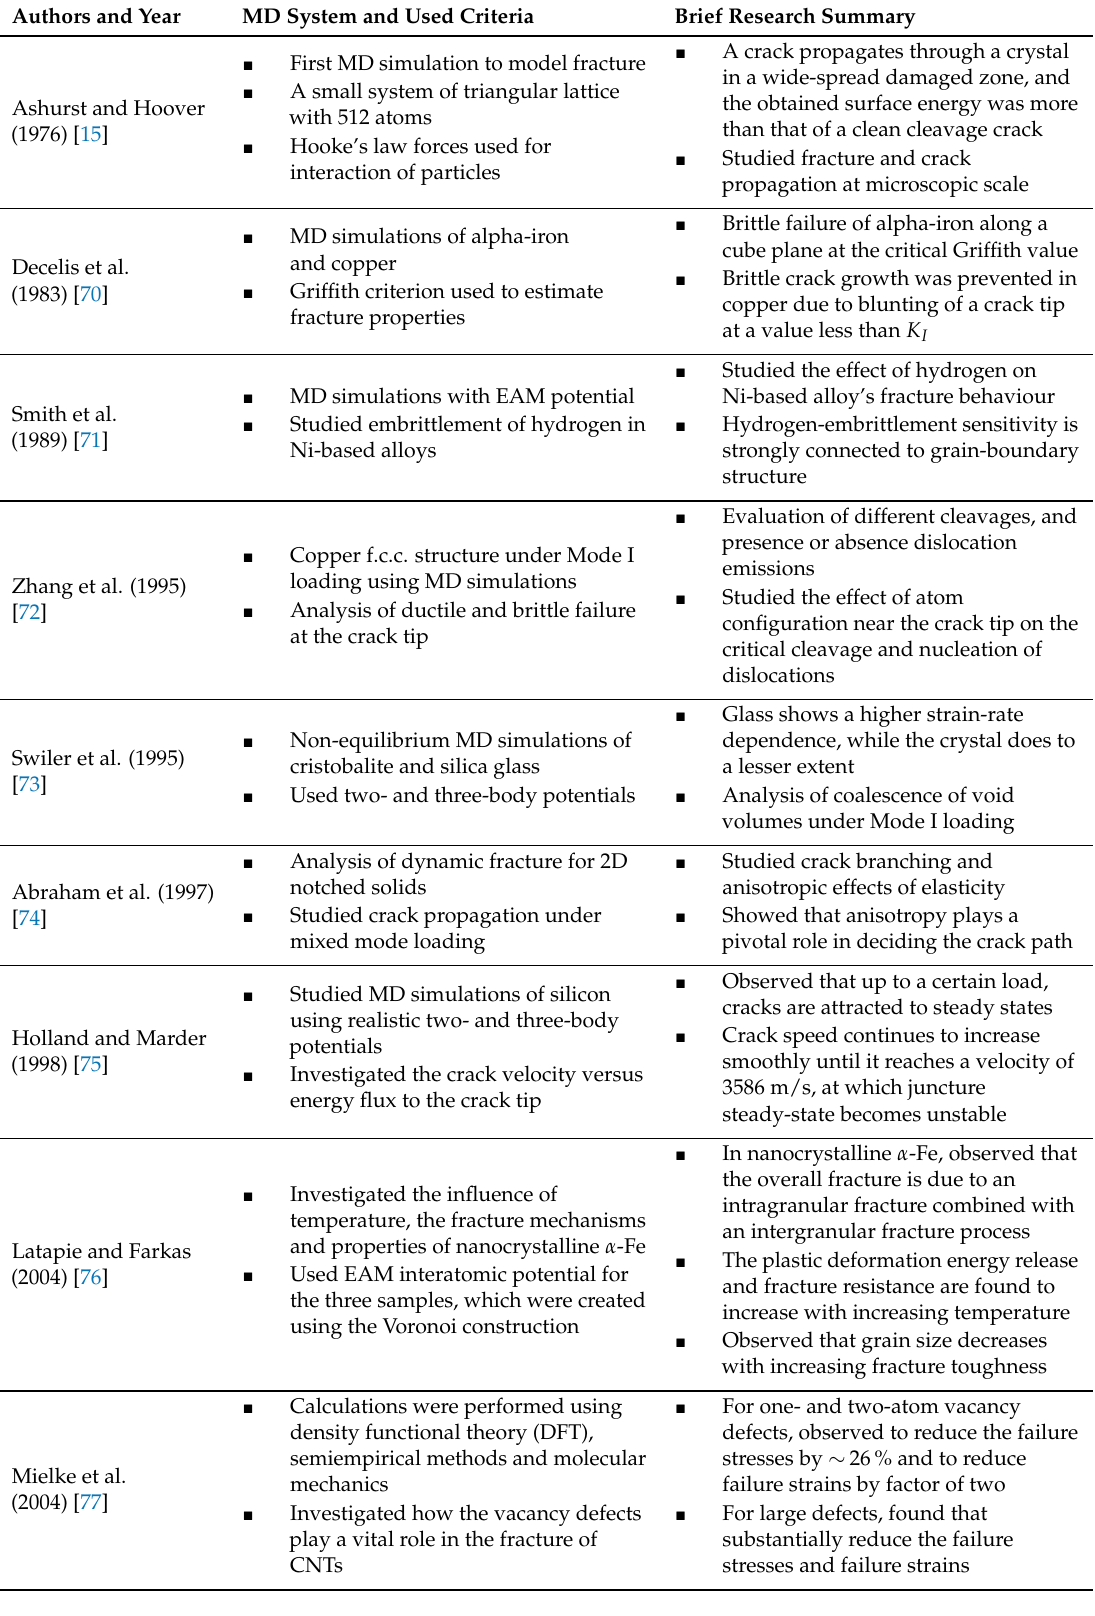
Table 1. Milestones in MD simulations to study brittle